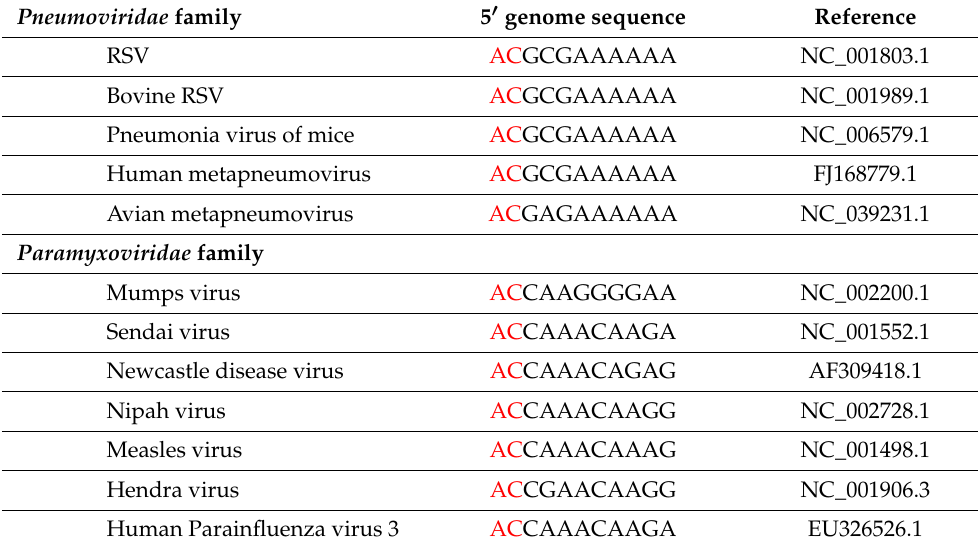
Table 1. Alignment of the 5 (cid:48) genome sequence of viruses for the Pneumoviridae and Paramyxoviridae families. The conserved sequence (AC) is shown in